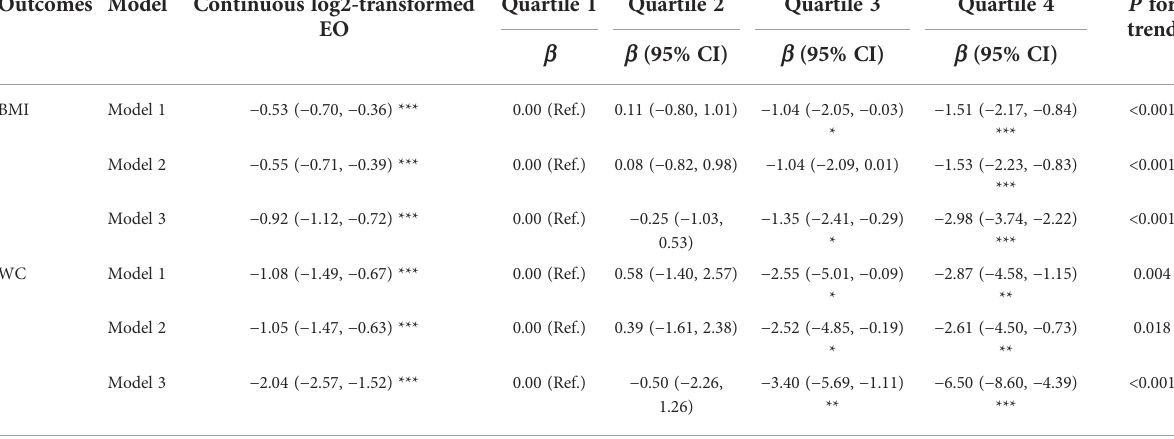
TABLE 2 Multiple linear regression associations of HbEO with anthropometric parameters in adults.